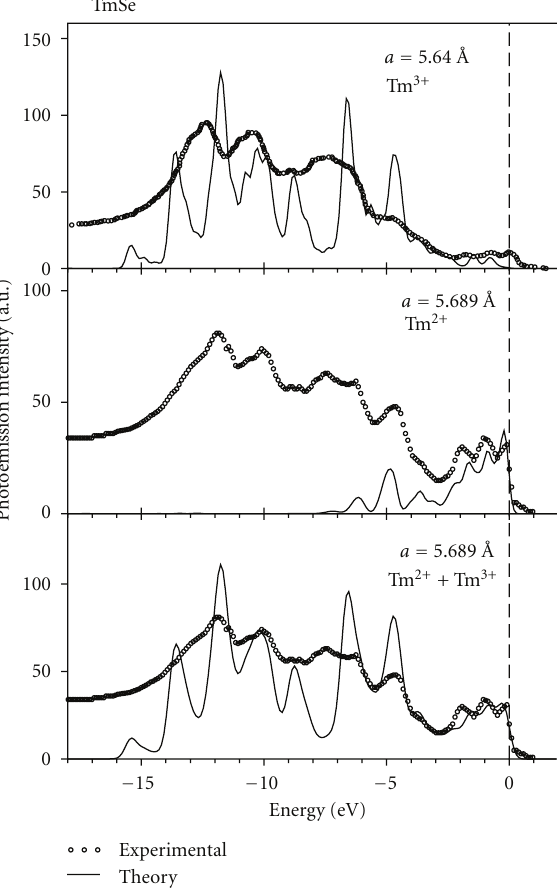
Figure 72: The calculated Tm 3+ and Tm 2+ 4 f DOS of TmSe in LSDA+ U approximations, taking into account the multiplet struc- ture of the 4 f 12 and 4 f 11 final states [384]. Comparison is made with the experimental XPS spectra from [346] measured for two di ff erent lattice